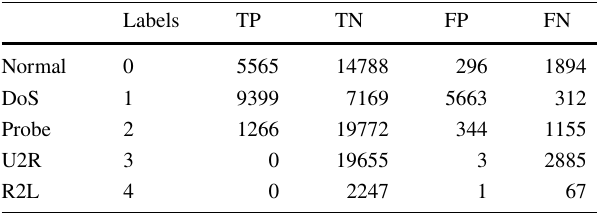
Table 10 Rates of attacks before feature selection